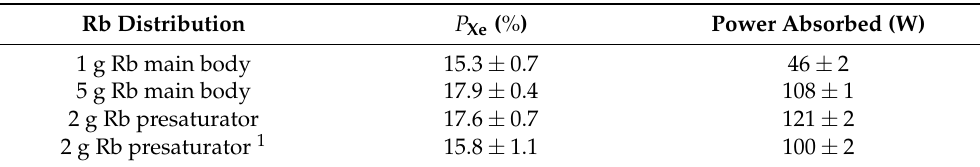
Table 3. Xe polarization, P Xe , and optical pumping laser power absorbed for each Rb SEOP cell tested.